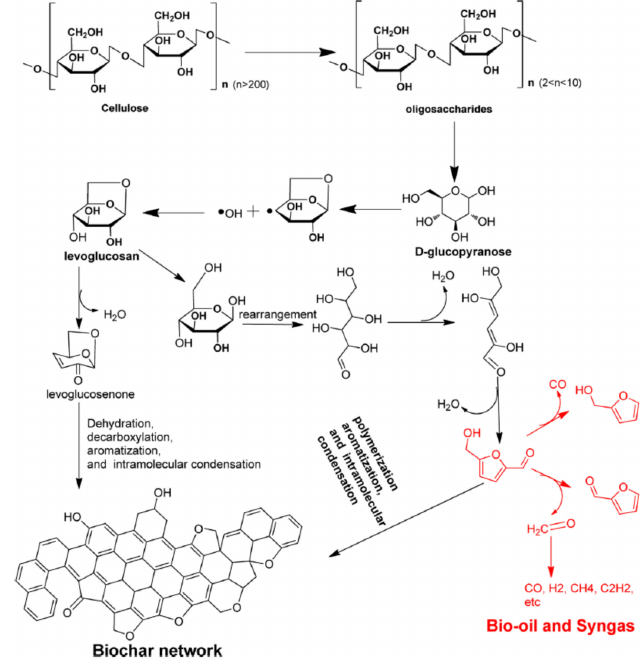
Figure 2. The mechanism of cellulose pyrolysis and biochar formation. Reprinted with permission from Reference [15]. Copyright (2015) American Chemical Society.